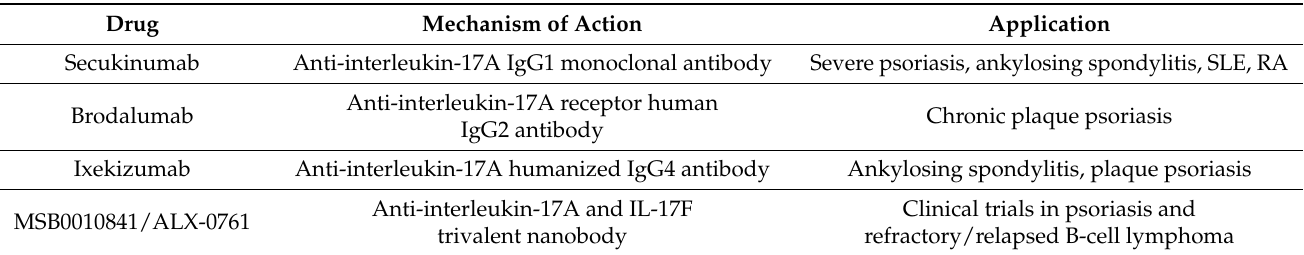
Table 1. Summarized overview of the mechanism of action of drugs targeting IL-17 axis and their current application in